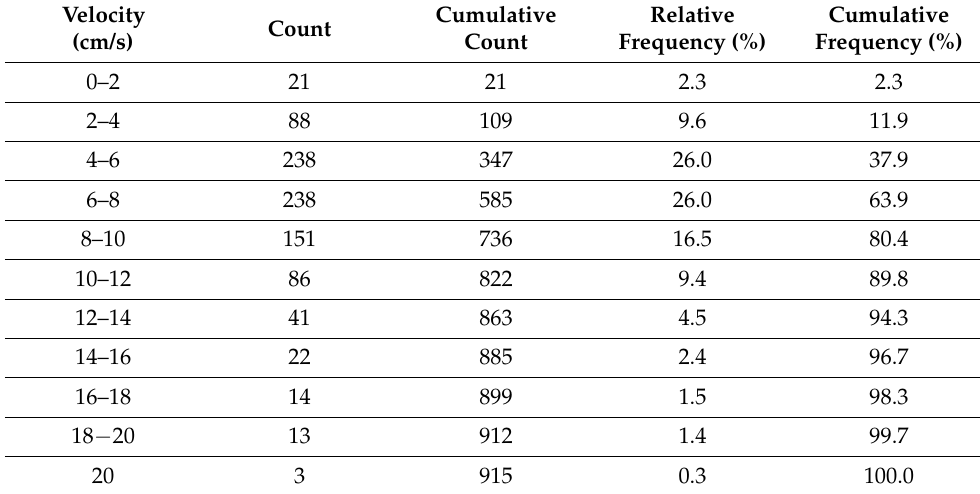
Table 4. Frequency of berthing